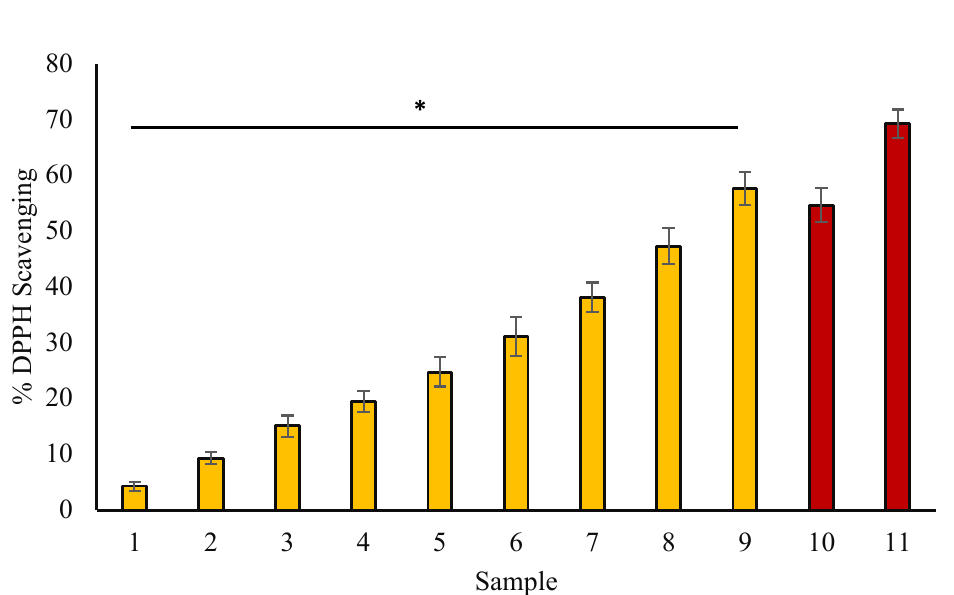
Figure 2. Percent of DPPH scavenged vs. concentration ( µ g/mL). Samples 1 to 9 (yellow bar) correspond to various concentrations of extract (50, 75, 100, 150, 200, 300, 400, 500, and 600 µ g/mL). Samples 10 and 11 (red bar) correspond to samples having 100 and 200 µ g/mL concentrations of ascorbic acid. The data are shown as means ± standard error of the means (n = 3, p < 0.05). The statistical differences are represented with an asterisk (*) for myrrh denoting significance at p < 0.05 in comparison with the reference sample.